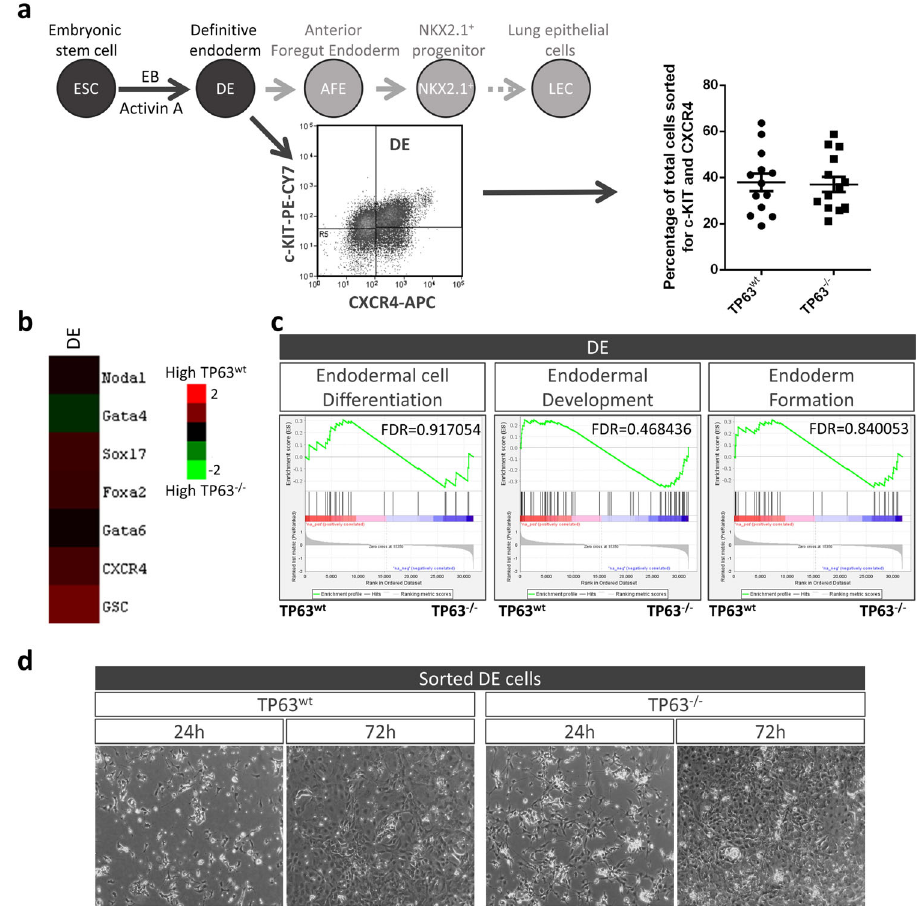
Fig. 3 TP63-de fi cient embryonic stem cells differentiate into de fi nitive endoderm. a- upper panel Schematic of ES cell differentiation into DE and lung progenitor cells. a- bottom panel Potential of TP63-de fi cient ES cells to differentiate into double-positive CXCR4/c-KIT DE cells (mean ± SEM, n ≥ 9 separate differentiations). b Heat map of endoderm-associated genes shows no difference in expression between freshly sorted wildtype and TP63-de fi cient DE cells. Measured by RNA-seq of CXCR4 + /c-KIT + sorted DE cells, n = 3 separate DE sorts. c GSEA con fi rms similarity (FDR > 0.1) of endoderm-associated gene expression between wildtype and TP63-de fi cient DE cells. d Attachment and proliferation of CXCR4 + /c-KIT + sorted wildtype and TP63 − / − DE cells plated on gelatin in SFDM without growth factors (representative of n = 3 separate DE